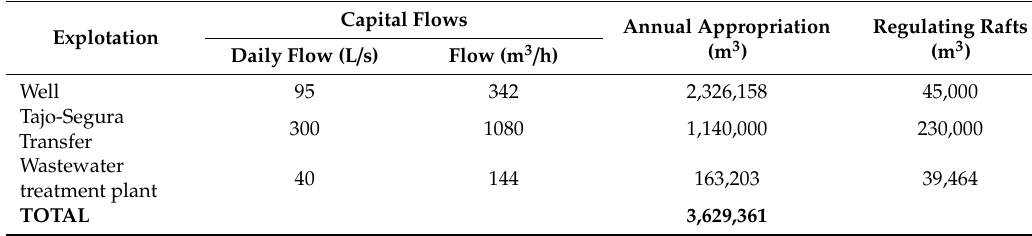
Table 1. Total volume supply of the available resources.